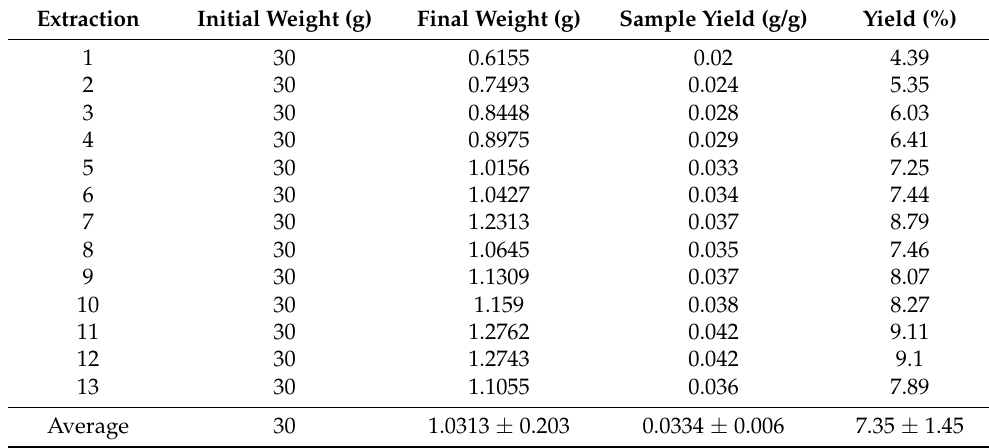
Table 2. Lignin yield from sorghum residues by the Organosolv method. Extraction Initial Weight (g) Final Weight (g) Sample Yield (g/g) Yield